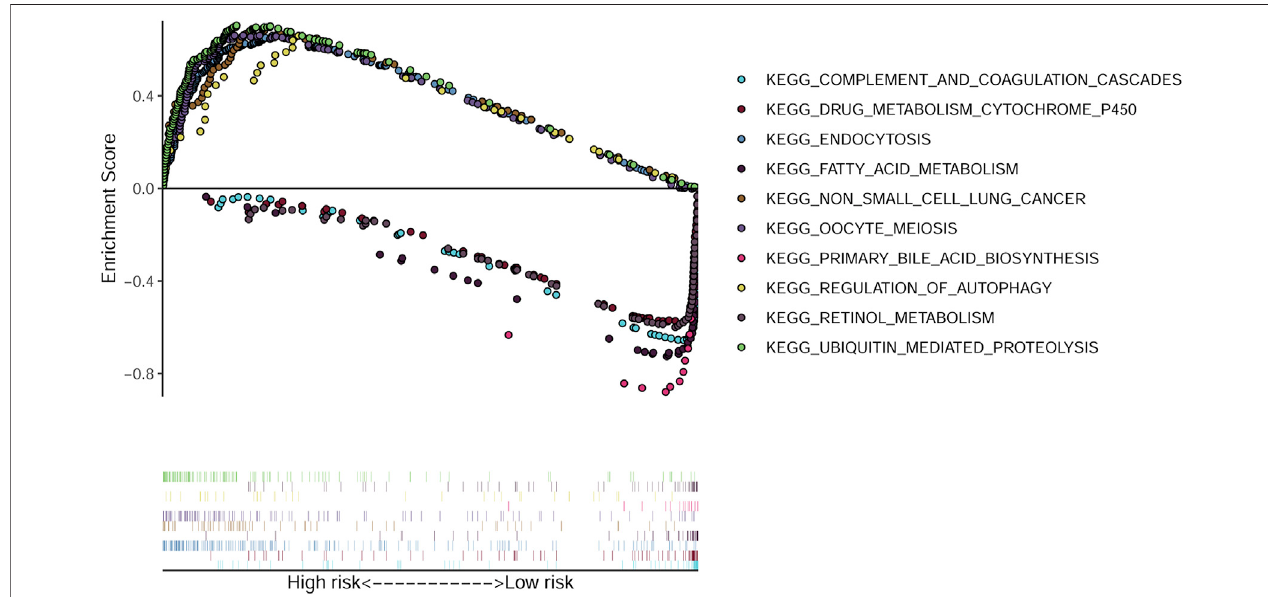
FIGURE 6 | GSEA analysis identi fi ed enriched KEGG pathways. The top fi ve enriched KEGG pathways in the high-risk and low-risk groups.